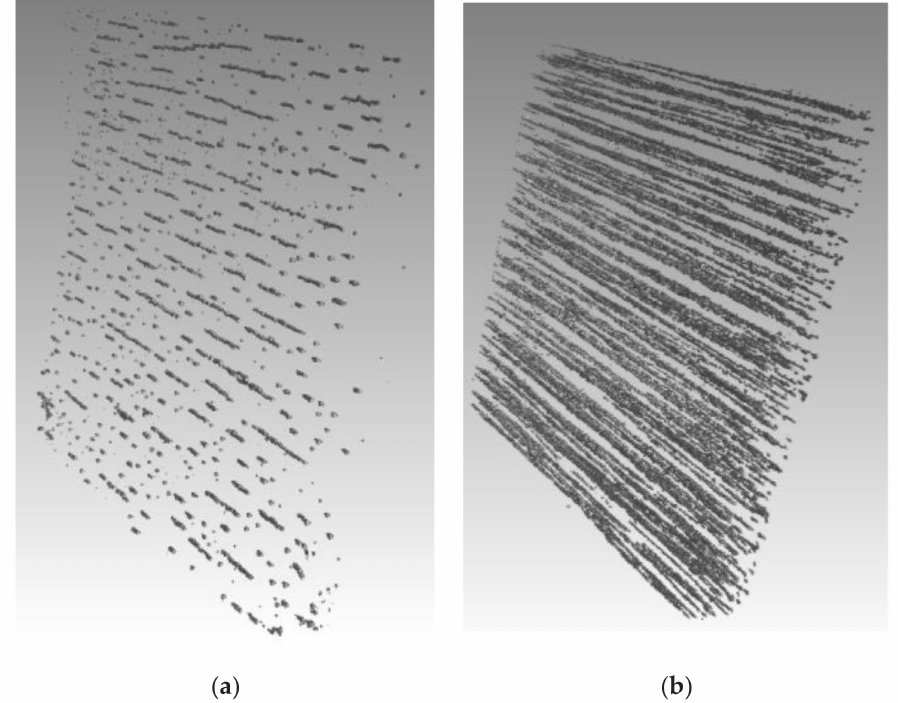
Figure 11. Three-dimensional visualization of the ( a ) short chains (obtained at H = 10 kA / m) and ( b ) bulk structures (obtained at H = 450 kA / m) of magnetic particles. The images were kindly provided by Dmitry Borin (TU Dresden) and were obtained using methods equivalent to those given in